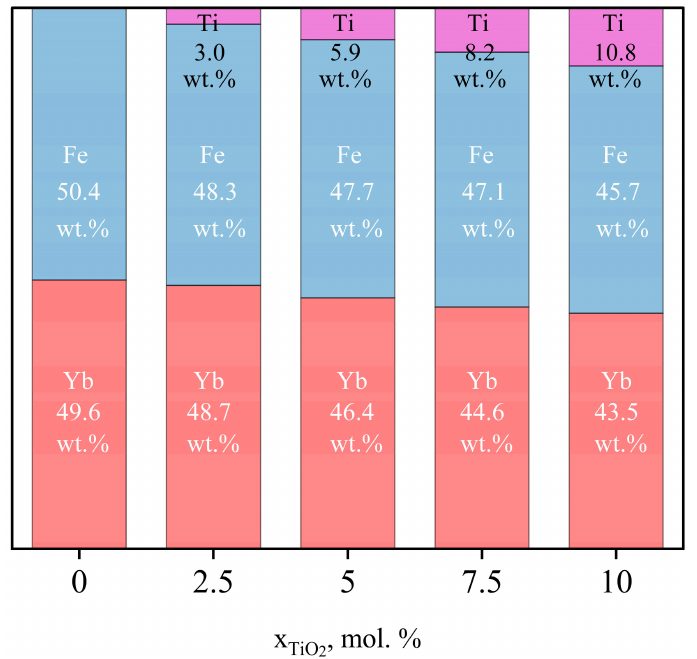
Figure 1. The elemental composition of samples concerning the main elements (in